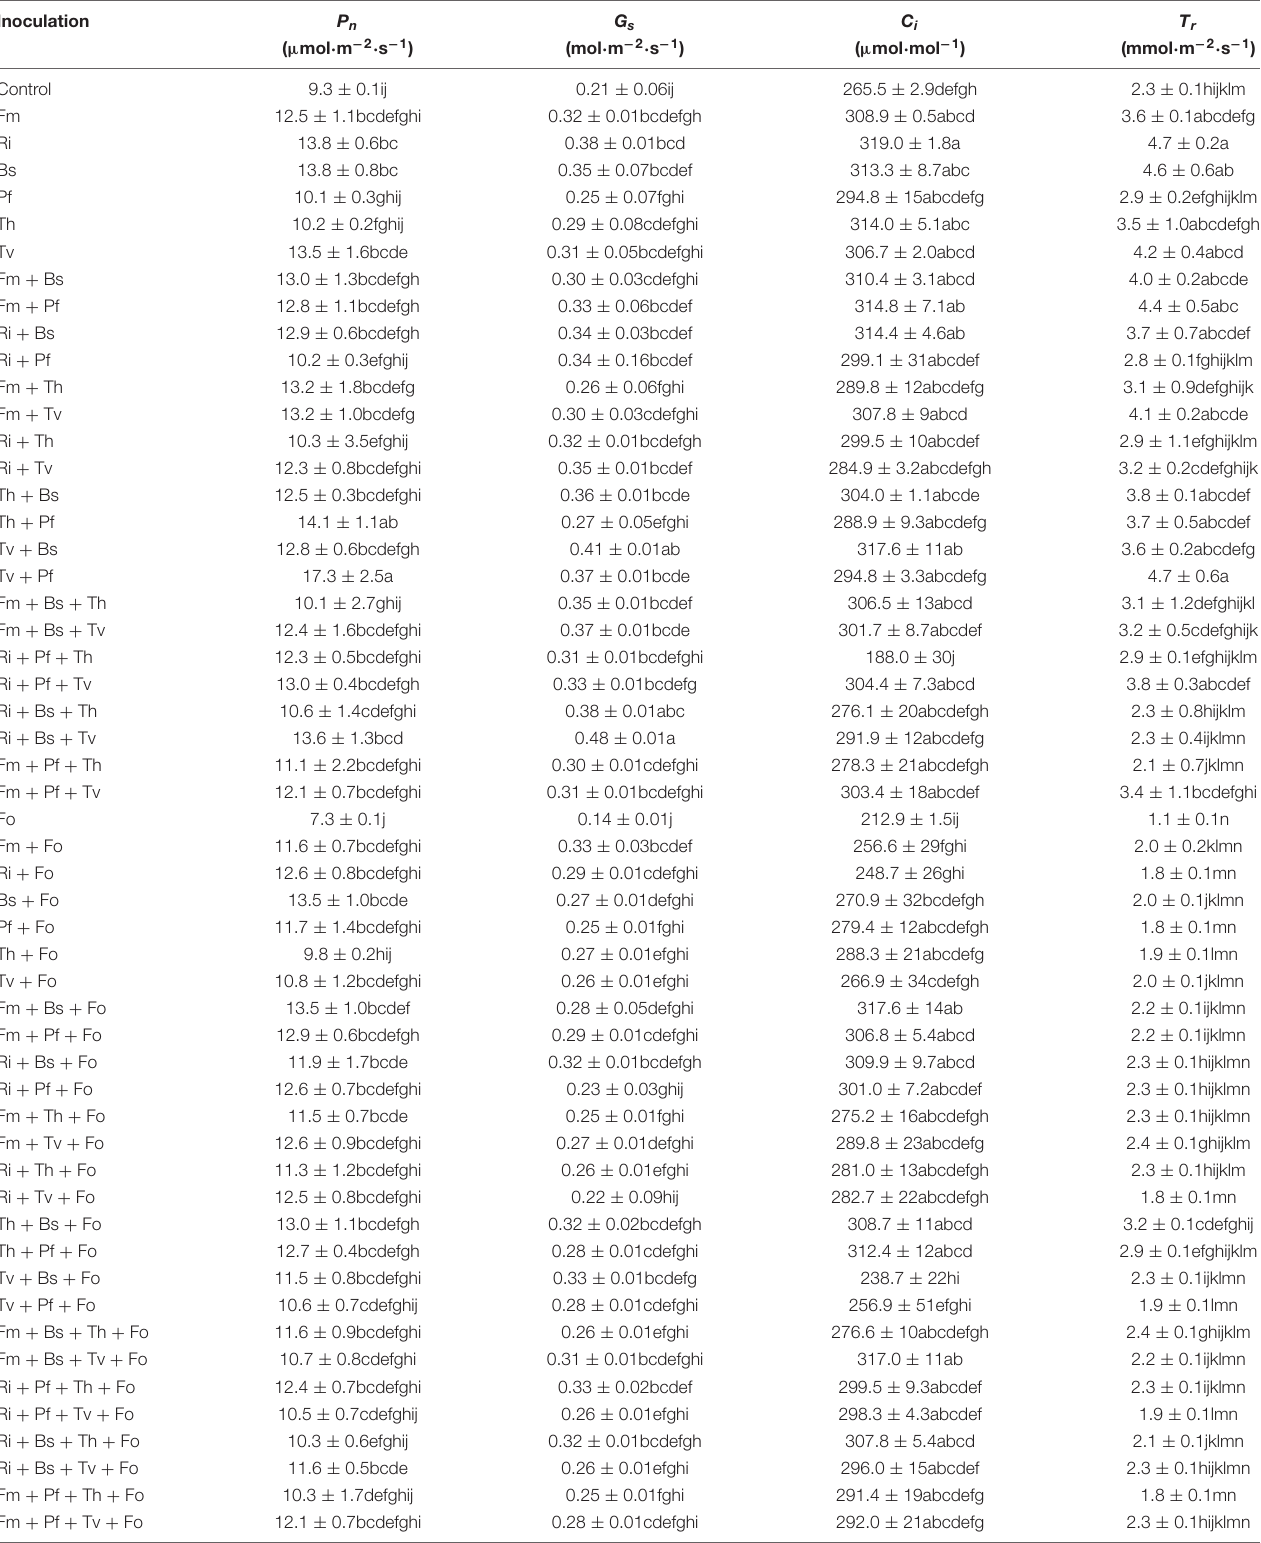
TABLE 4 | Influences of AMF, PGPR, Trichoderma spp., and Fusarium oxysporum f. sp. radicis-lycopersici on tomato leaf photosynthetic performance.